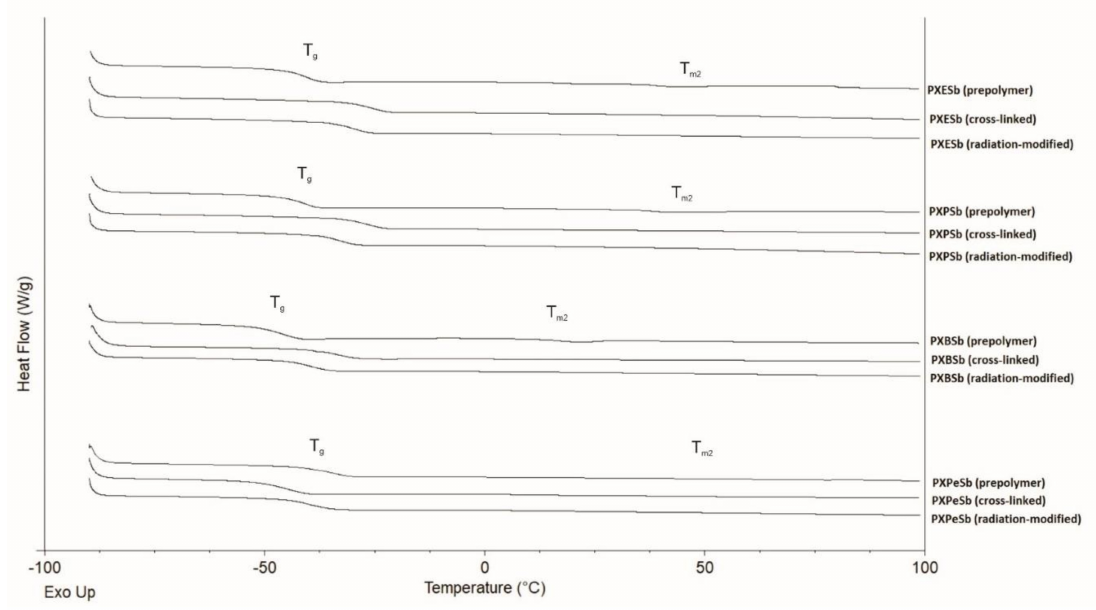
Figure 8. DSC thermograms (first-heating) of PXESb, PXPSb, PXBSb, and PXPeSb prepolymers, cross-linked polymers, and radiation-modified polymers.